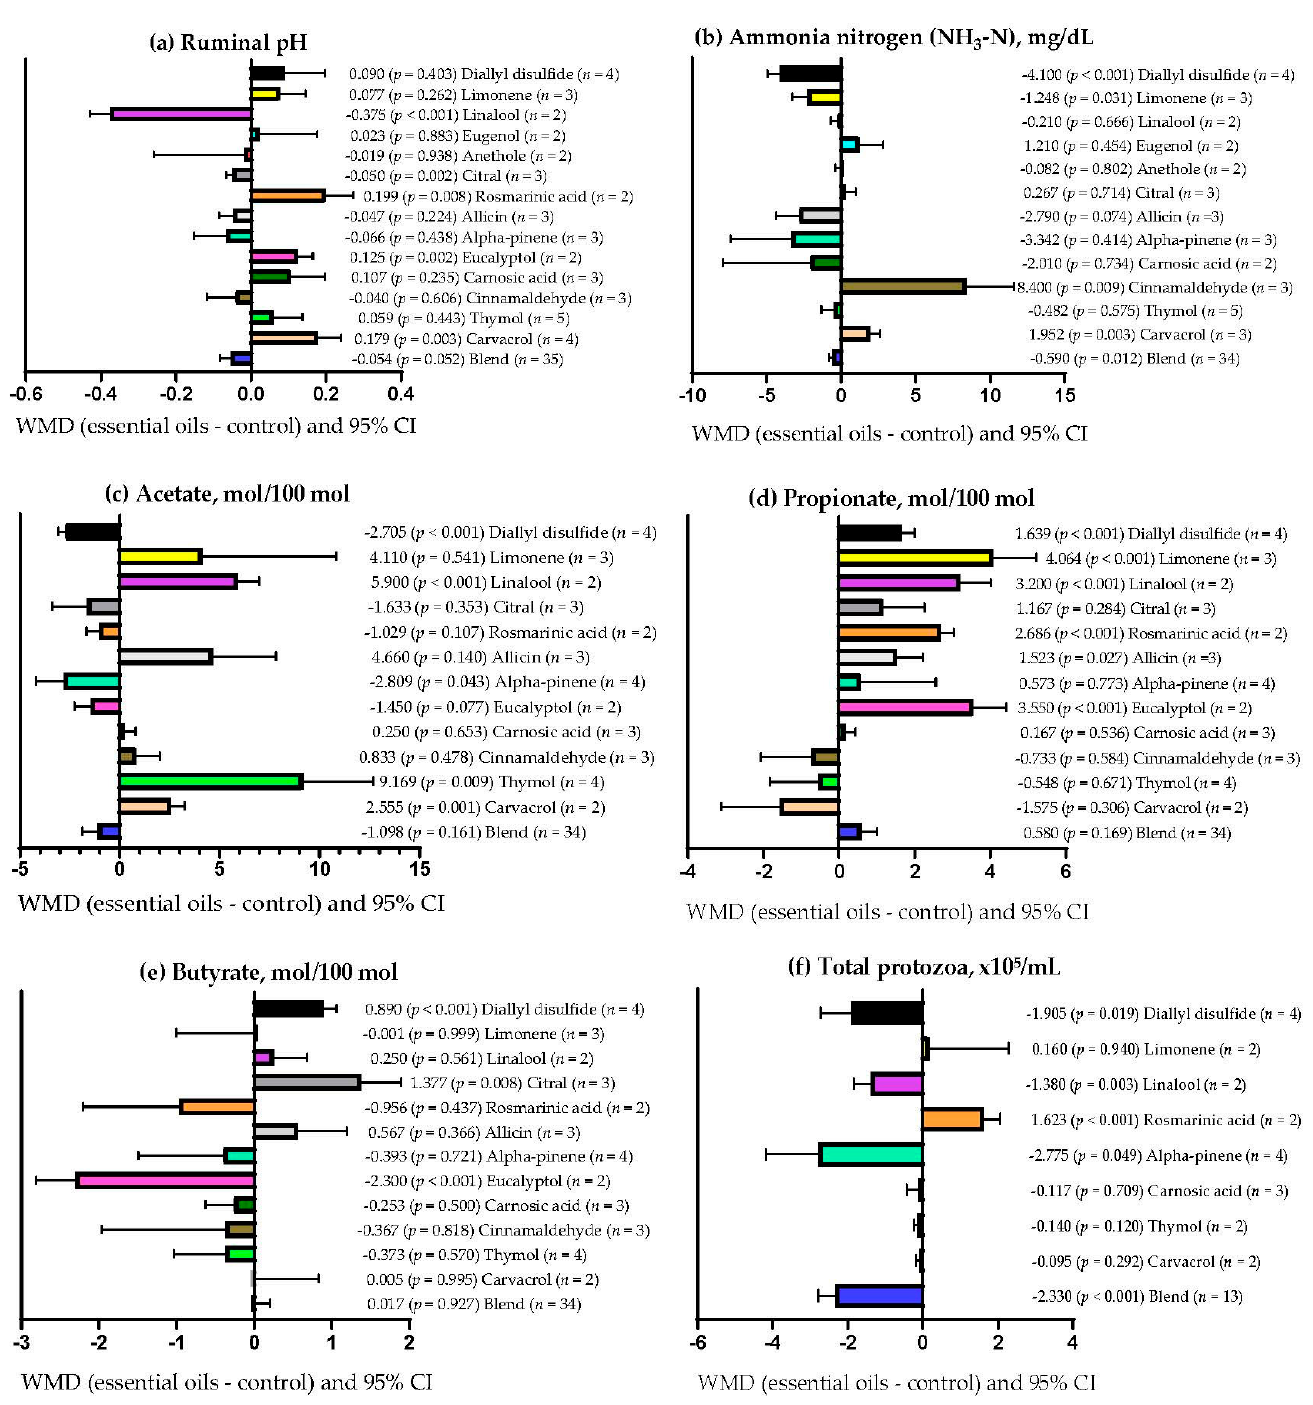
Figure 4. Subgroup analysis (subgroup = primary bioactive compound) of the effect of essential oils supplementation on small ruminants’ diets on their rumen parameters; WMD = weighted mean differences between essential oil treatments and